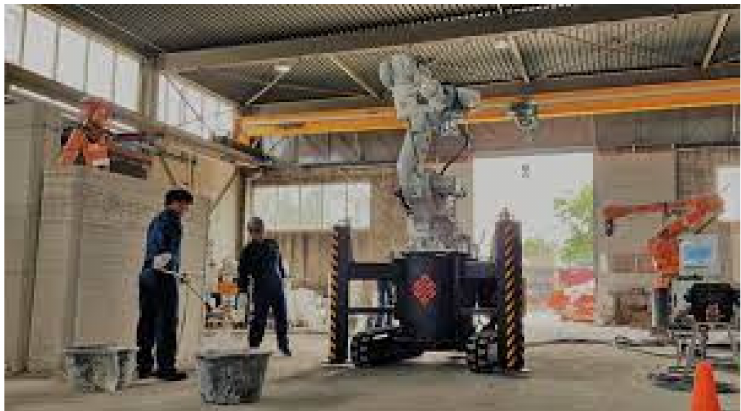
Figure 17. CyBe Printer on “Crawler System” [47]. Reprinted with permission from Ref. [47]. 2022,